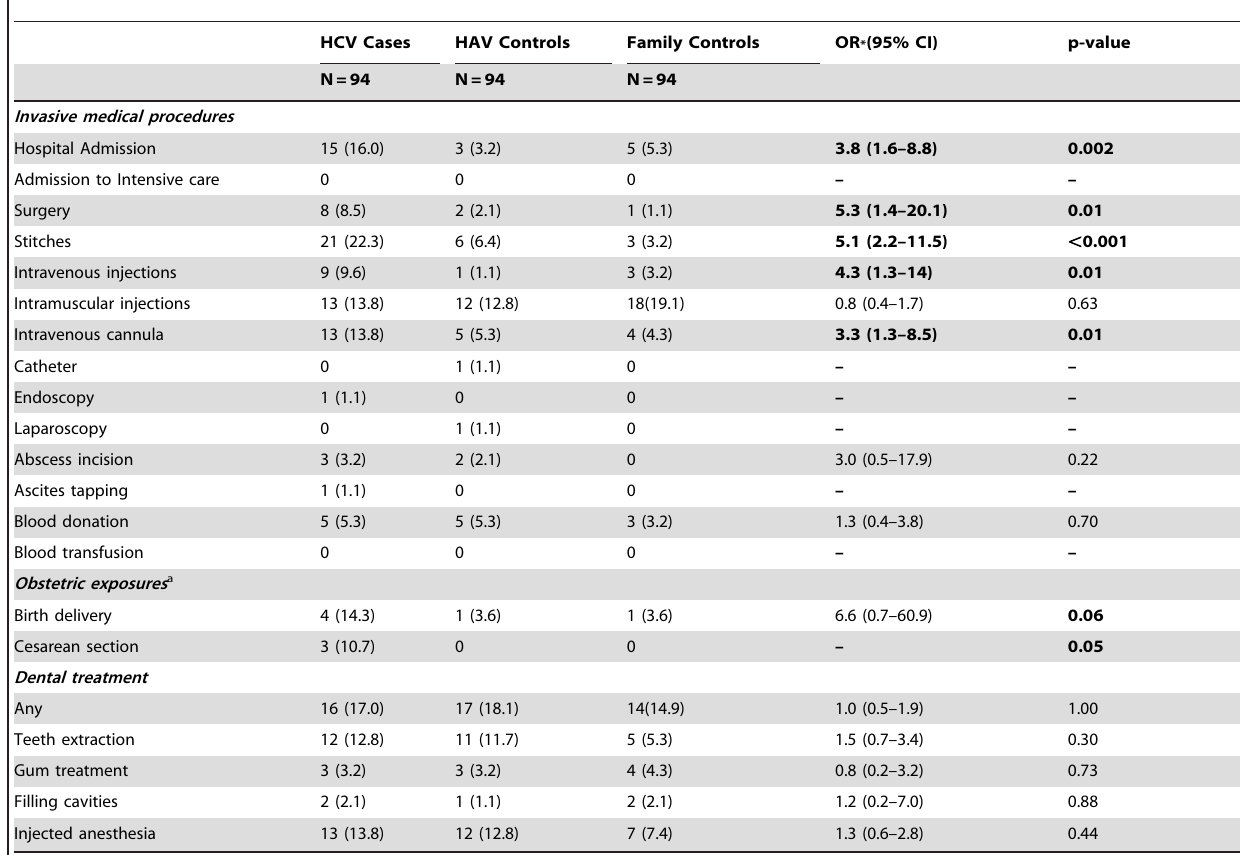
Table 2. Health care related risk factors among acute hepatitis C cases and controls sex- and 6 1 year age-matched, Greater Cairo, 2002-7.